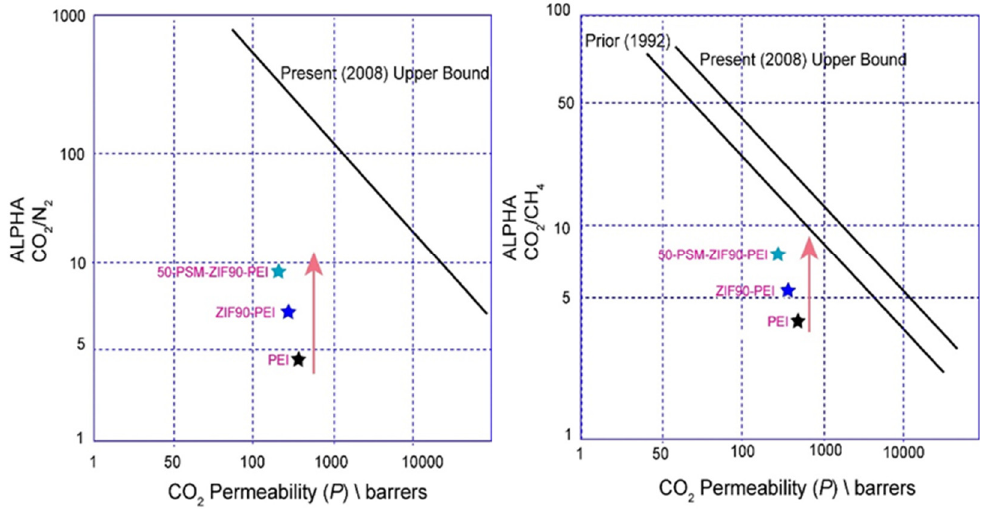
Figure 15. Comparison of CO 2 separation performance of Pure PEI membrane, ZIF-90 PEI and 50-PSM-ZIF-90 PEI membranes on Robeson’s Upper Bound.